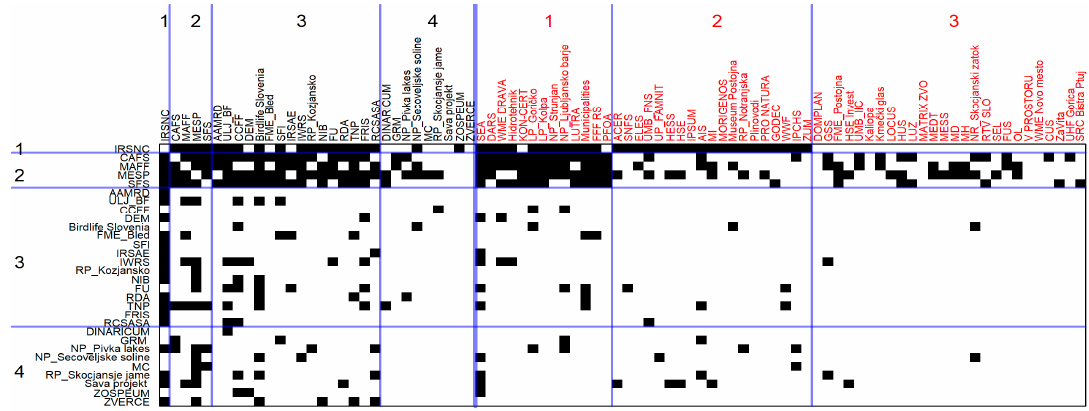
Figure 4. Results of homogeneity generalized blockmodeling of the cooperation network with removed isolates (print in colour).